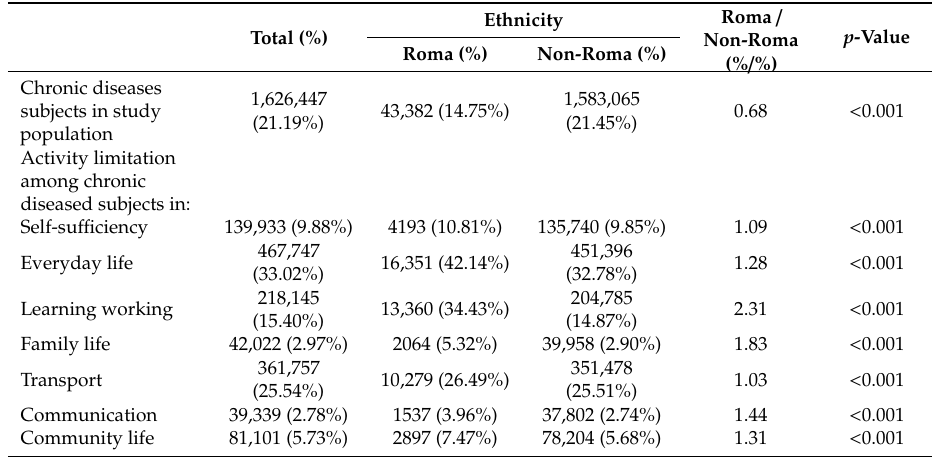
Table 2. Crude prevalence of having at least one chronic disease and the prevalence of activity limitations among subjects with chronic disease by functions in Hungary, according to the 2011 census, evaluated by χ 2 -test (more detailed descriptive statistics are summarized in Table A2).